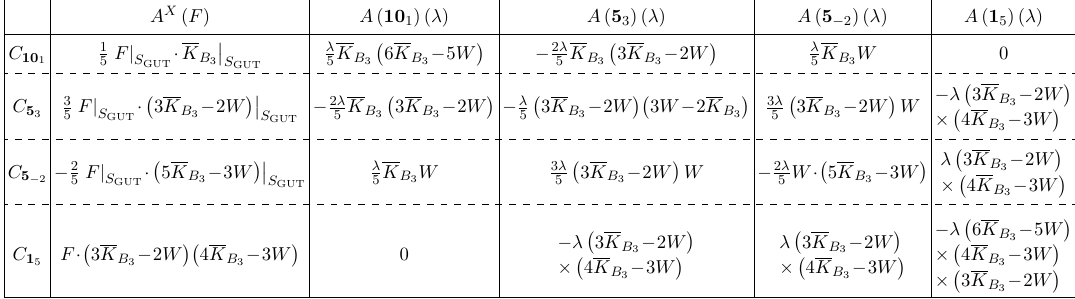
Table 4. Chiralities of the massless spectra of the (cid:13)uxes A X ( F ), A ( 10 1 )( (cid:21) ), A ( 5 3 )( (cid:21) ), A ( 5 (cid:0) 2 )( (cid:21) ) and A ( 1 5 )( (cid:21) ). These chiralities include the contributions from the spin bundle. which automatically satis(cid:12)es the transversality conditions (3.8) and (3.9) but of course violates, by construction, (3.3). Here C 2 CH ( W ) denotes any curve on the 7-brane 1 divisor. For instance, the hypercharge (cid:13)ux takes the form [90, 92,